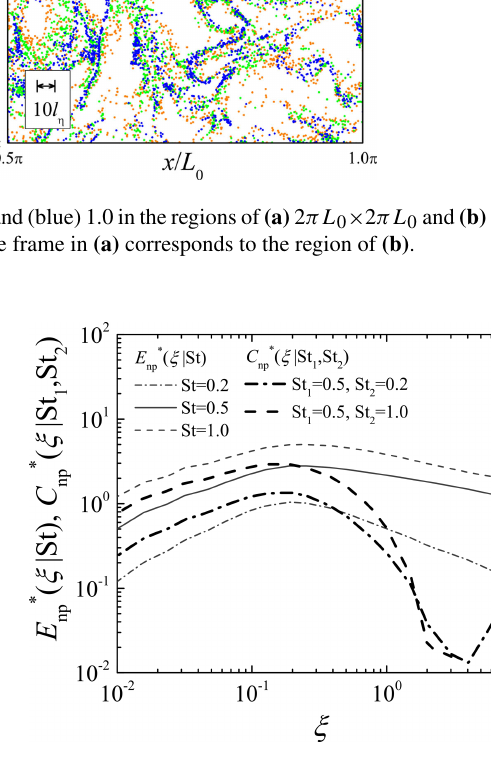
Figure 2. Normalized cross spectra C ∗ np (ξ | St 1 , St 2 ) of droplet number density fluctuations compared to normalized power spec- tra E ∗ np (ξ | St)